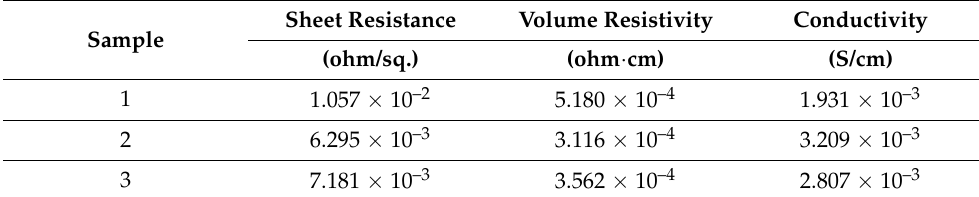
Table 1. Electrical properties of the IrO 2 catalyst electrodes coated on porous Ti power